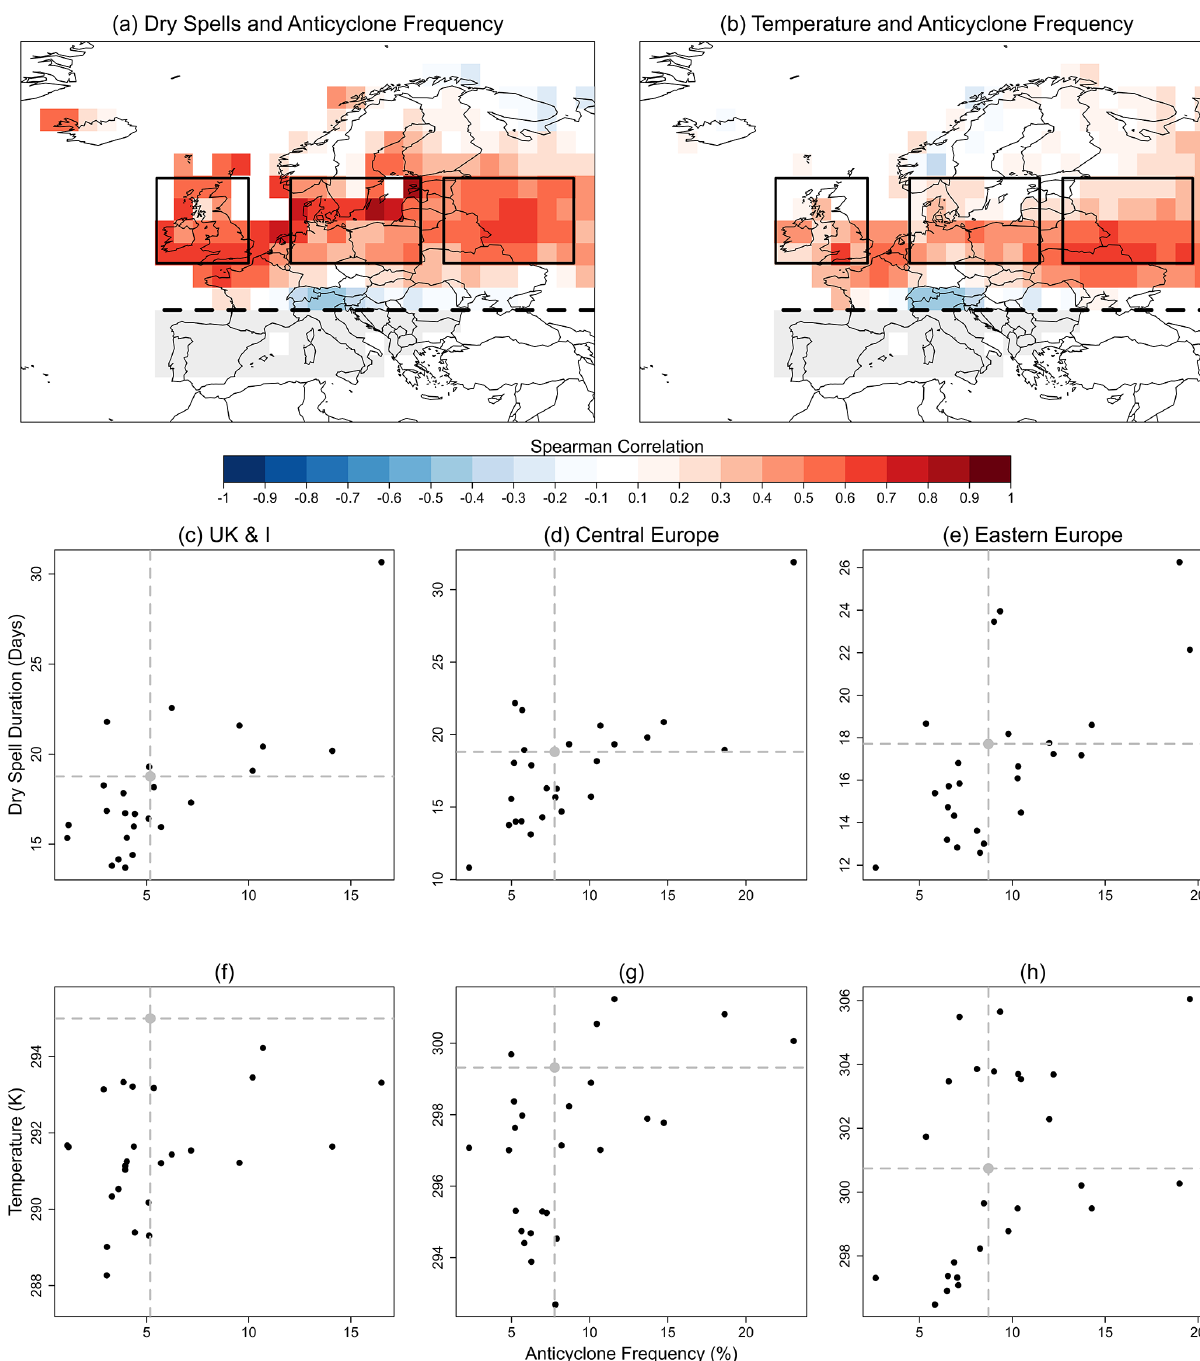
Figure 8. Relationship between frequency of anticyclonic systems (ASs), that last for at least 5d, with 5-year RLs of dry spell durations (RL DS ) and with the average maximum temperature from dry spells longer than 5d (Tx DS ). Inter-model Spearman’s rank correlation coef- ficients between (a) AS frequency and RL DS and (b) AS frequency and Tx DS . The scatter plots show inter-model relationships between AS frequency and RL DS averaged over (c) UK & Ireland, (d) central Europe, and (e) eastern Europe, as well as AS frequency and Tx DS averaged over (f) UK & Ireland, (g) central Europe, and (h) eastern Europe. Each point represents a model, while the grey dot in each panel represents the metrics obtained from EOBS (RL DS , Tx DS ) and ERA5 (AS frequency). The three regions used to demonstrate these relationships are indicated by the black boxes in (a) . Grey areas indicate the masked grid cells below 40 ◦ N marked by the dashed black